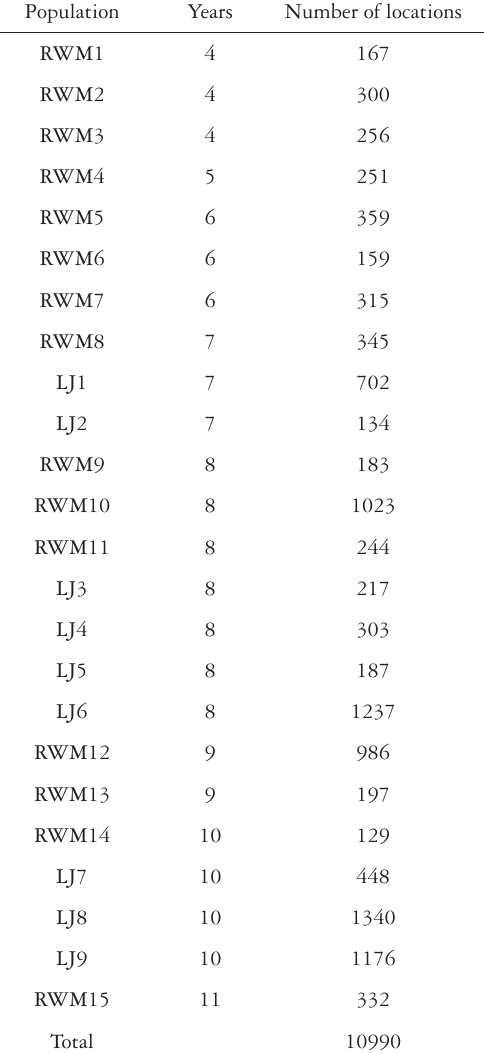
Table 1. A list individual caribou, their associated popu- lation, total number of years monitored, and the corresponding number of ARGOS and/or GPS telemetry data